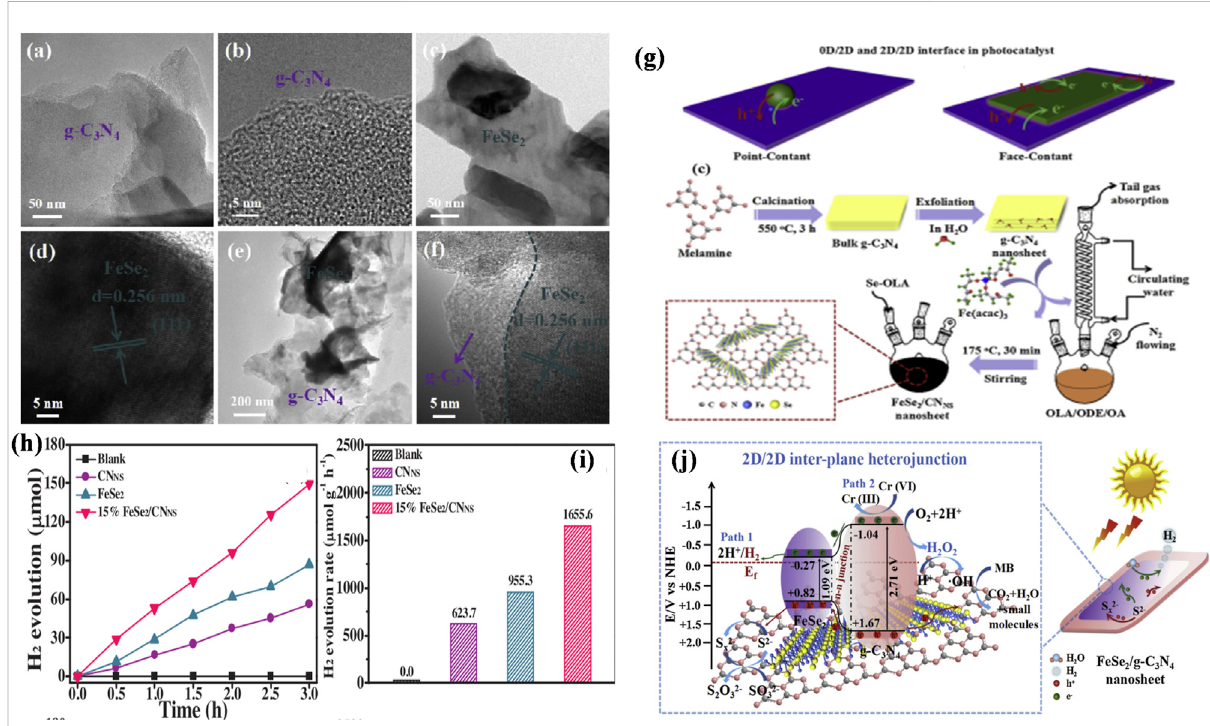
FIGURE 7 TEM image of pristine g-C 3 N 4 (A,B) , FeSe 2 nanosheets (C,D) , and FeSe 2 /CNNS composite of 15% sample (E,F) . Schematic image depicting the interfaces of (G) 0D/2D heterostructures, 2D/2D heterostructures and Schematic diagram for the fabrication process of inter-plane hetero- structuresof2D/2DFeSe 2 /CNNS.Photocatalytichydrogenevolutionplot (H) andrates (I) ofvirging-C 3 N 4 ,FeSe 2 ,andheterostructuresofnumerous FeSe 2 /CNNS. (J) Schematic depiction of the charge carrier transport in 2D/2D FeSe 2 /CNNS samples irradiated by sunlight. Reproduced